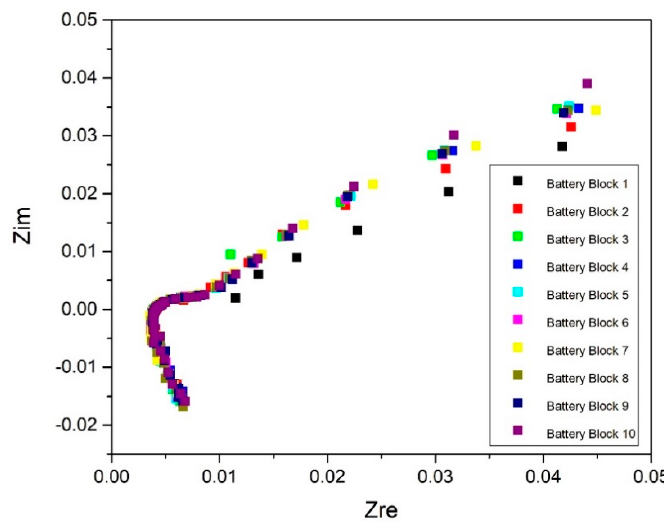
Figure 7. EIS measurement dispersion from 10 different 12 V lead–acid battery blocks.